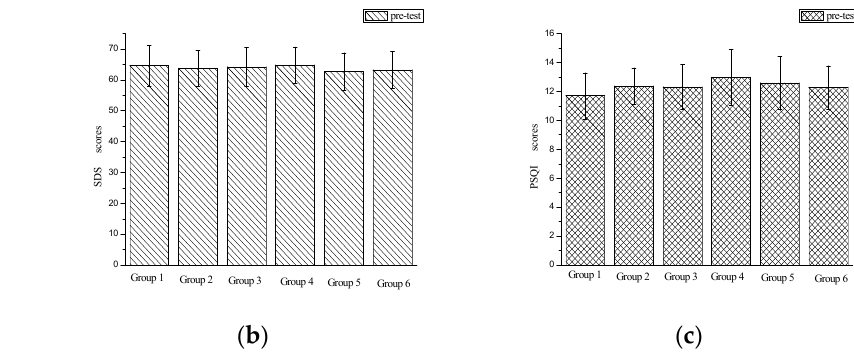
Figure 2. Pre-test results of participants’ anxiety, depression and sleep quality. ( a ) Pre-test results of participants’ anxiety; ( b ) pre-test results of participants’ depression; ( c ) pre-test results of participants’ sleep quality.